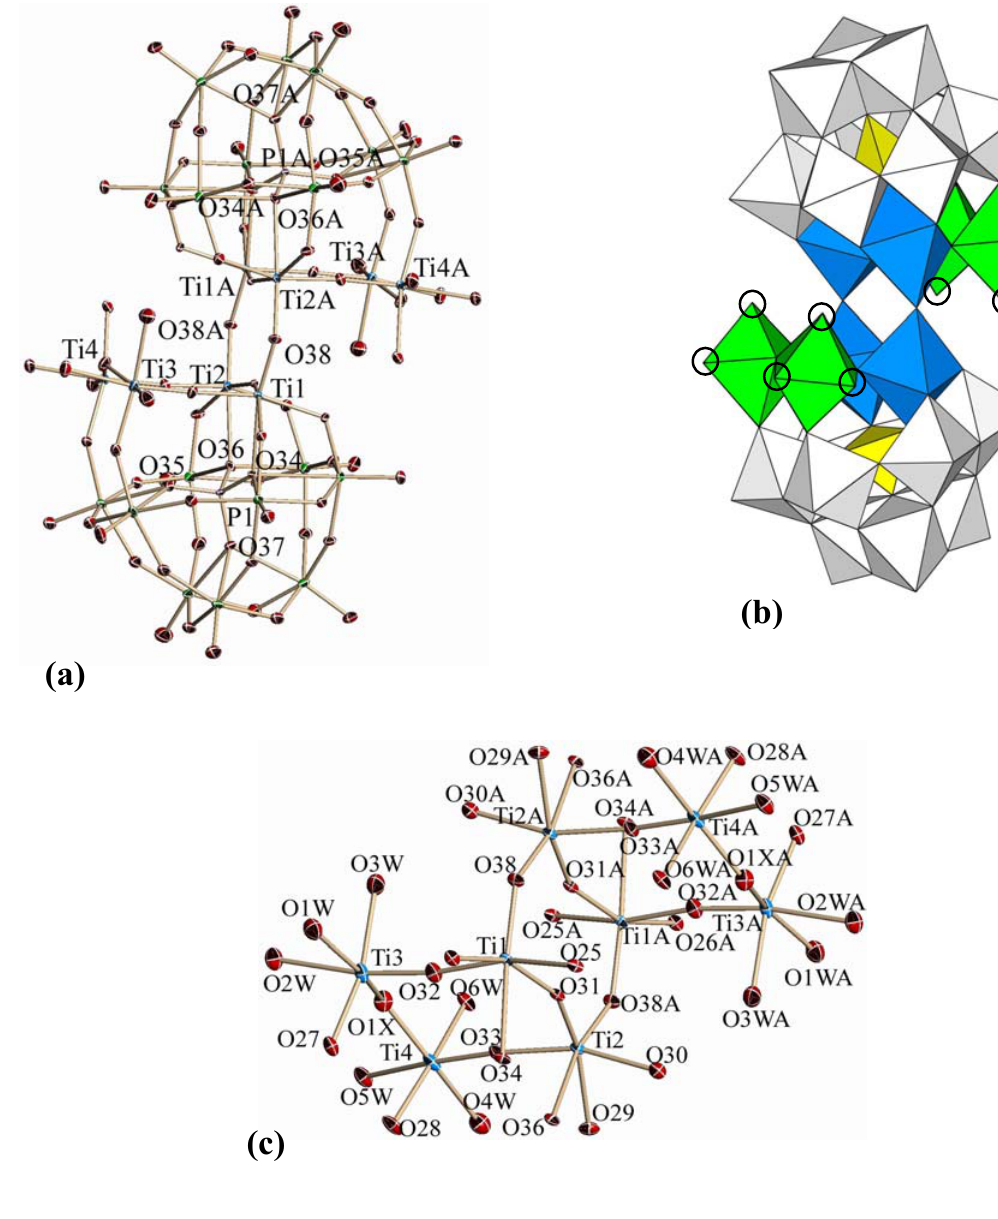
O) } ( μ -O)]( α - 2 3 2 octahedra are shown in gray and the two 6 (green) 6